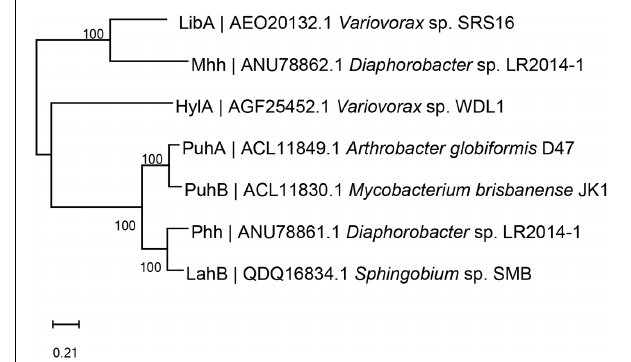
FIGURE 4 | Phylogenetic tree of the key phenylurea herbicide initial hydrolysis enzymes constructed via neighbor-joining method (amino acid sequences). Code before strain name is National Center for Biotechnology Information accession number. PuhA was isolated from Arthrobacter globiformis D47 (Khurana et al., 2009). PuhB was isolated from Mycobacterium brisbanense JK1 (Khurana et al., 2009). LibA was isolated from Variovorax sp. SRS16 (Sørensen et al., 2005). HylA was isolated from Variovorax sp. WDL1 (Dejonghe et al., 2003). Phh and Mhh were isolated from Diaphorobacter sp. LR2014-1 (Zhang et al., 2018). LahB was isolated from Sphingobium sp. SMB (Zhang et al.,